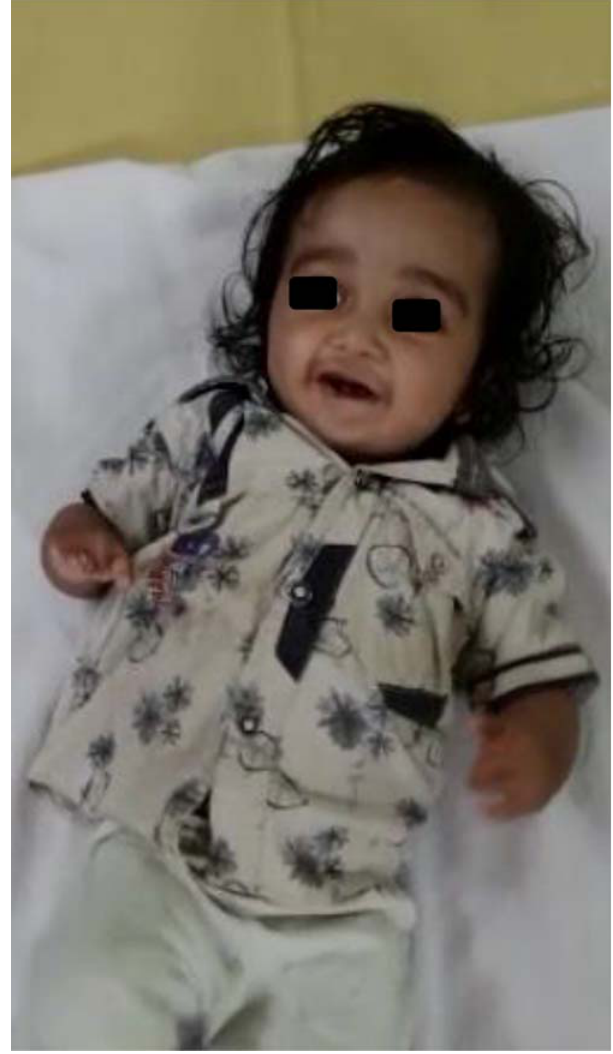
Fig. 5. 4 months post-operative mouth